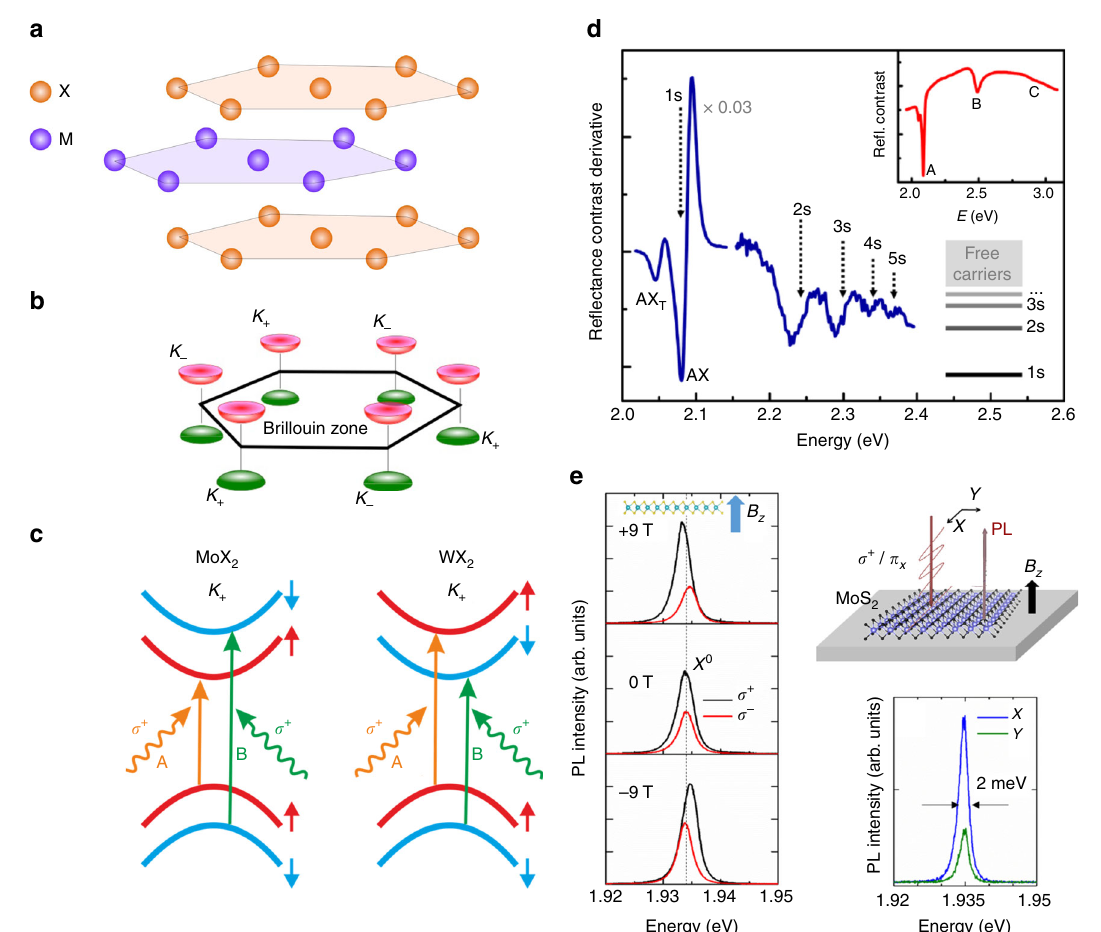
Fig. 1 Crystal and band structure of semiconducting TMDCs. a Schematic view of TMDC monolayer crystal structure. b Band structure of TMDC monolayer with direct optical band gap at K points. c Valley-speci fi c selection rules for molybdenum-based (MoX 2 and tungsten-based (WX 2 )) compounds. d Evolution of exciton states for WS 2 monolayer on SiO 2 2 , reproduced from Chernikov et al. 2 © American Physical Society. e Optical valley initilization and valley coherence generation for a MoS 2 monolayer encapsulated in hBN 45 reproduced from Cadiz et al.